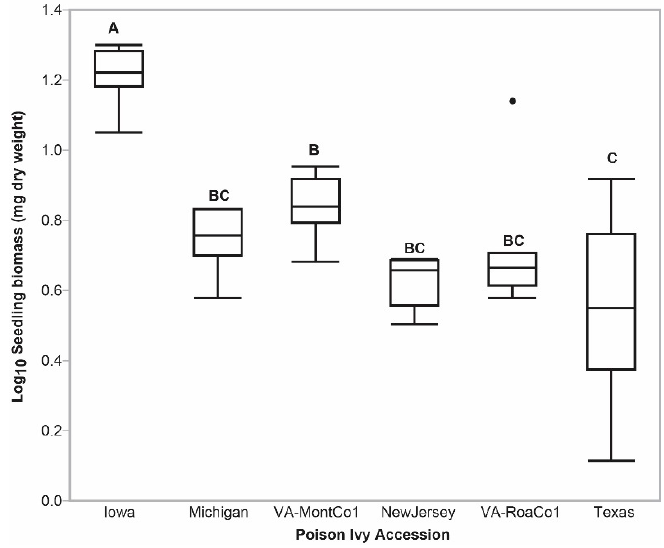
Figure 4. Poison ivy seedling biomass outlier box plots. Box plots that share at least one letter are not significantly different ( p -value > 0.0500).